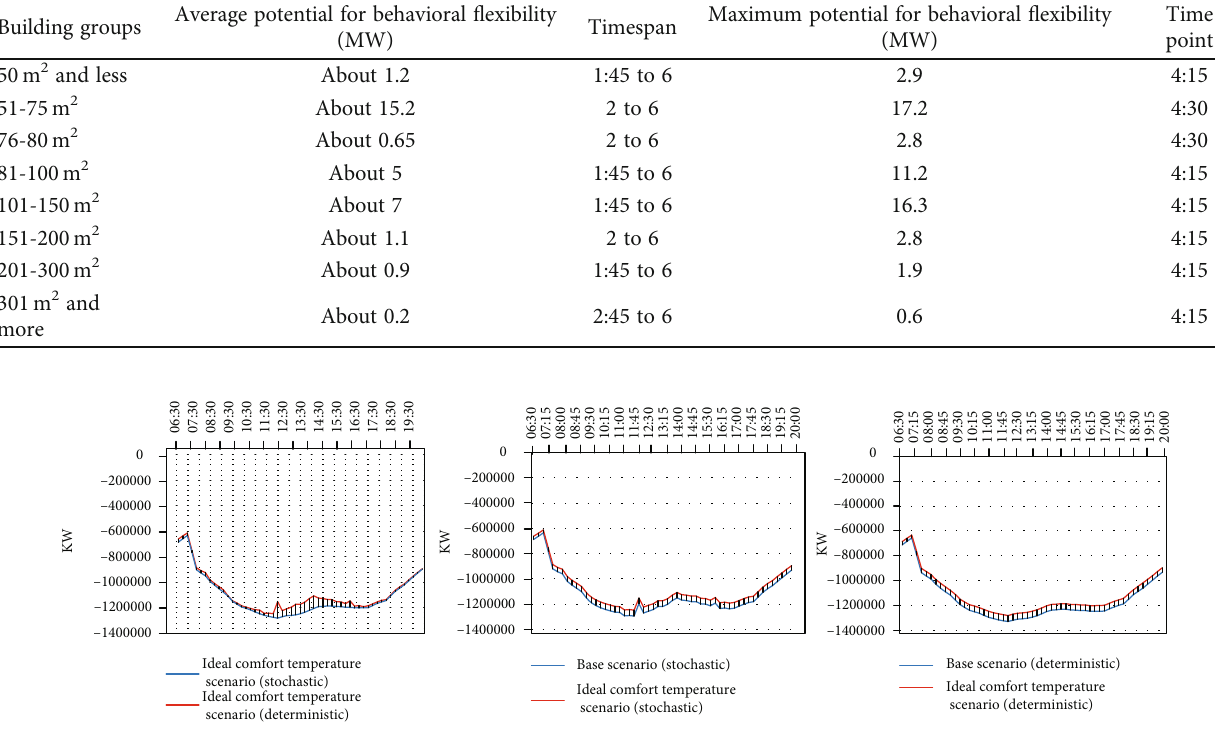
Figure 20: Di ff erent modes in the ideal comfort temperature scenario (day).